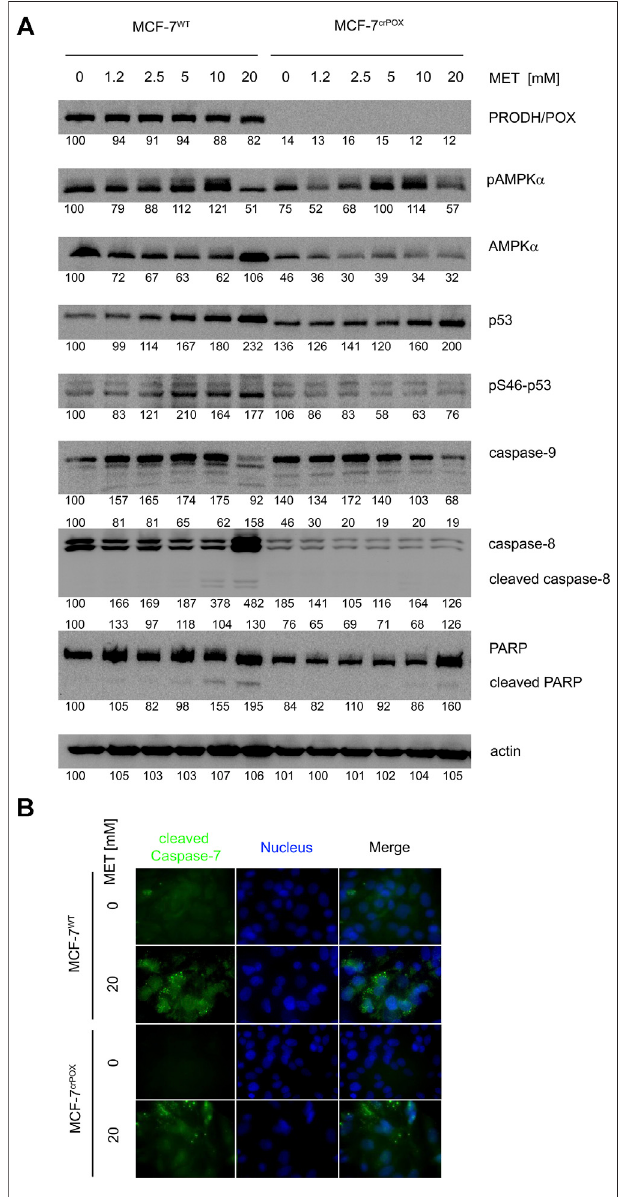
FIGURE 3 | Western blot of some proteins involved in proline metabolism and apoptosis (A) and immuno fl uorescence bioimaging of cleaved caspase-7 (B) in wild-type MCF-7 cells (MCF-7 WT ) and knocked- down PRODH/POX MCF-7 cells (MCF-7 crPOX ) treated with metformin (MET, 0 – 20 mM) for 48 h in glutamine-free medium. Representative blot images are shown (the mean value of the densitometric analysis of protein bands is presented below each